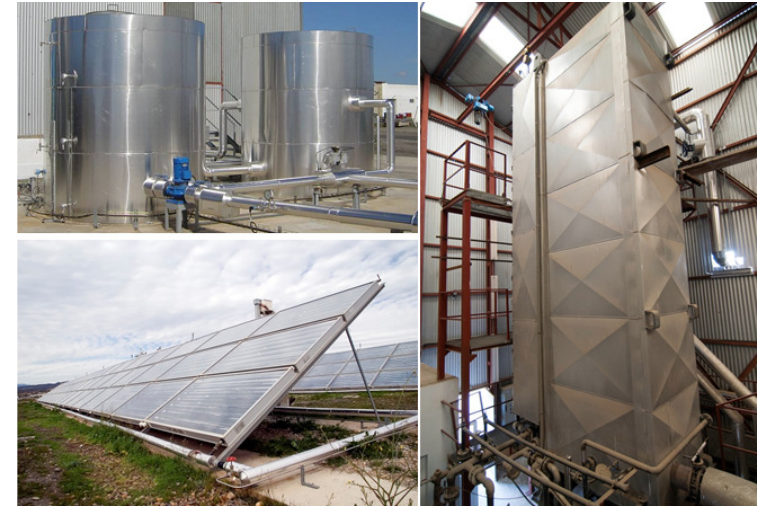
Figure 2. Solar desalination facility at PSA-CIEMAT. From left to right and from top to bottom: cold and hot tanks, MED unit and solar